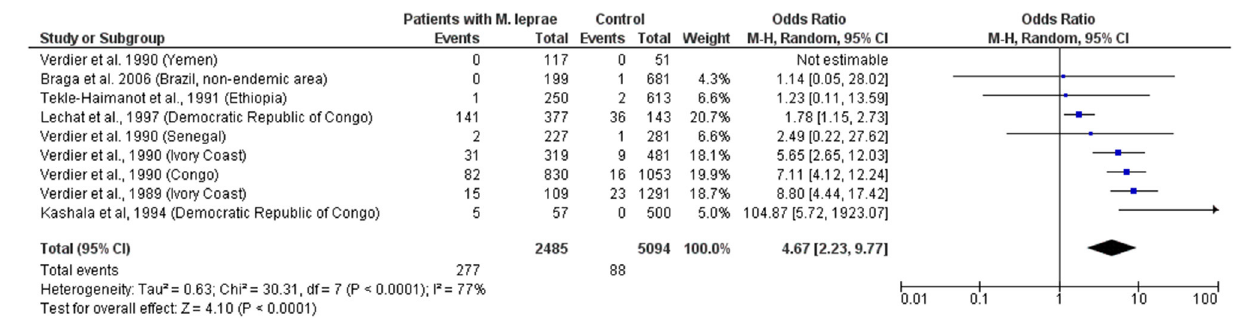
FIGURE 2 | Forest Plot and meta-analysis showing the Odds Ratio of HTLV-1 infection in patients with Mycobaterium leprae. The boxes and lines indicate the odds ratios (ORs) and their confidence intervals (CIs) for each study. The pooled odds ratio is represented by a black diamond. The size of the blue squares indicates the relative weight of each estimate. Statistical analysis and graph were performed using RevMan 5 Software. Odds Ratio was calculated using Random effects model and Mantel-Haenszel statistical method. Measures of heterogeneity between studies is shown.